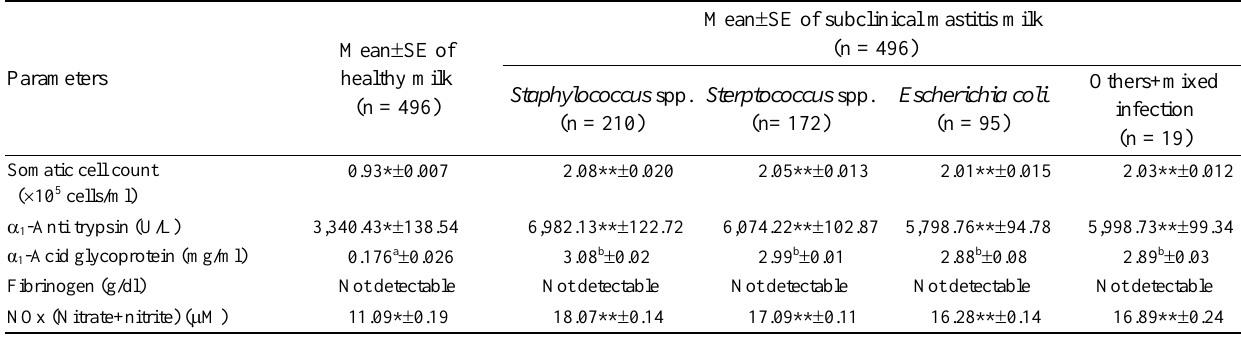
Table 2. Effect of different bacterial agents on acute phase proteins and NOx in healthy and subclinical mastitis milk of riverine buffalo ( Bubalus bubalis )